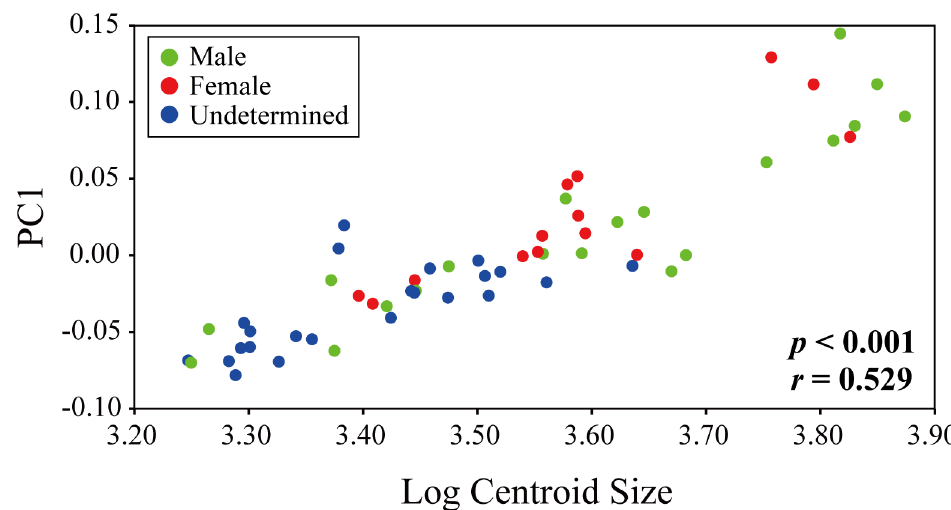
Fig 4. PCA and variation in brain shape for each principal component (PC) score.